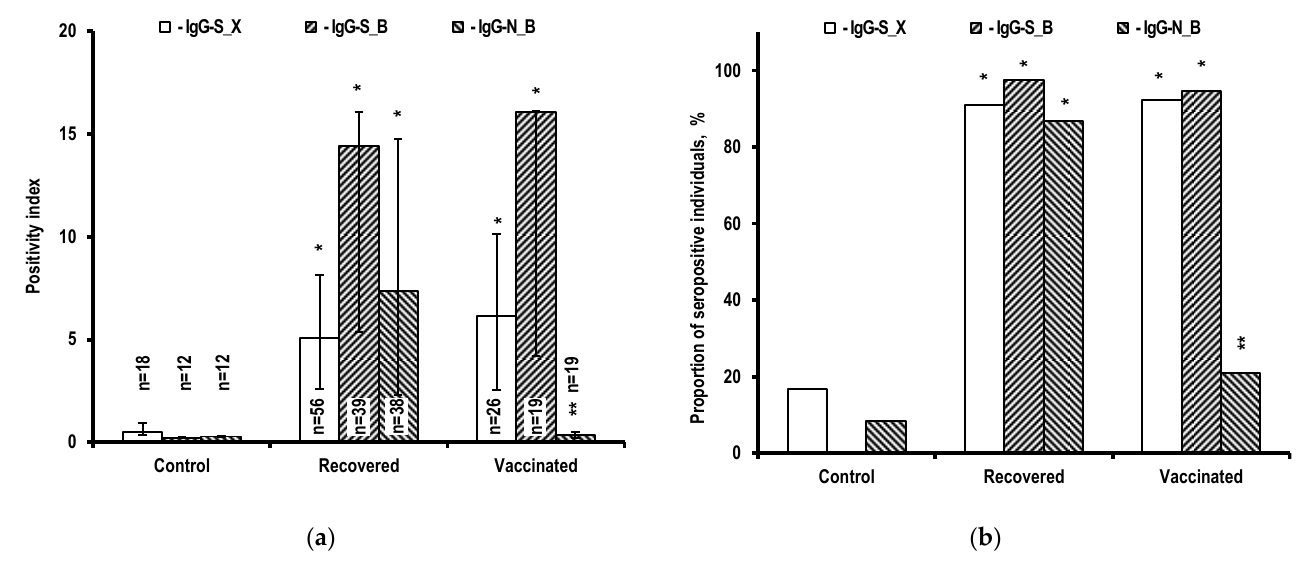
Figure 3. Results of the assay for serum detection of antibodies to SARS ‐ CoV ‐ 2 protein antigens in the examined individuals. ( a ) Positivity indices (PIs) based on ELISA results. The data are presented as Me (Q1; Q3). ( b ) Proportions of seropositive individuals (PI > 1.1) in the examined groups, with regard to SARS ‐ CoV ‐ 2 protein antigens. * p < 0.01 when compared to serum samples of controls using the same method. ** p < 0.01 when compared to serum samples of recovered individuals using the same method.